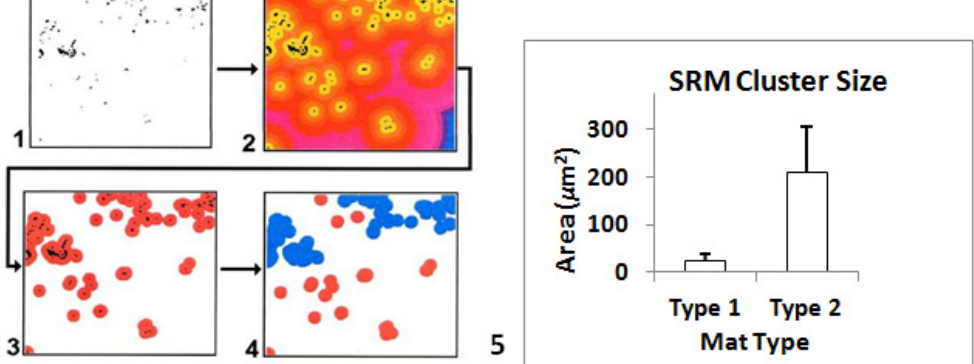
Figure 6. Scheme illustrating detection of SRM clusters using GIS. ( 1 ) CSLM micrograph showing SRM cells labeled with dsrA probe with background digitally-removed, and identification of individual SRM cells ( i.e. , black dots); ( 2 ) generation of artificial concentric regions with same width (10 µm) around each cell or group of cells; ( 3 ) identification of overlapping concentric regions; ( 4 ) statistical selection of clusters based on area (e.g., overlapping areas of > five cells); ( 5 ) Graph showing cluster sizes of SRM cells in Type-1 and Type-2 mats. Means and 95% confidence intervals are expressed as areas for SRM clusters. Note the significantly larger sizes and variability in cluster-sizes detected in Type-2